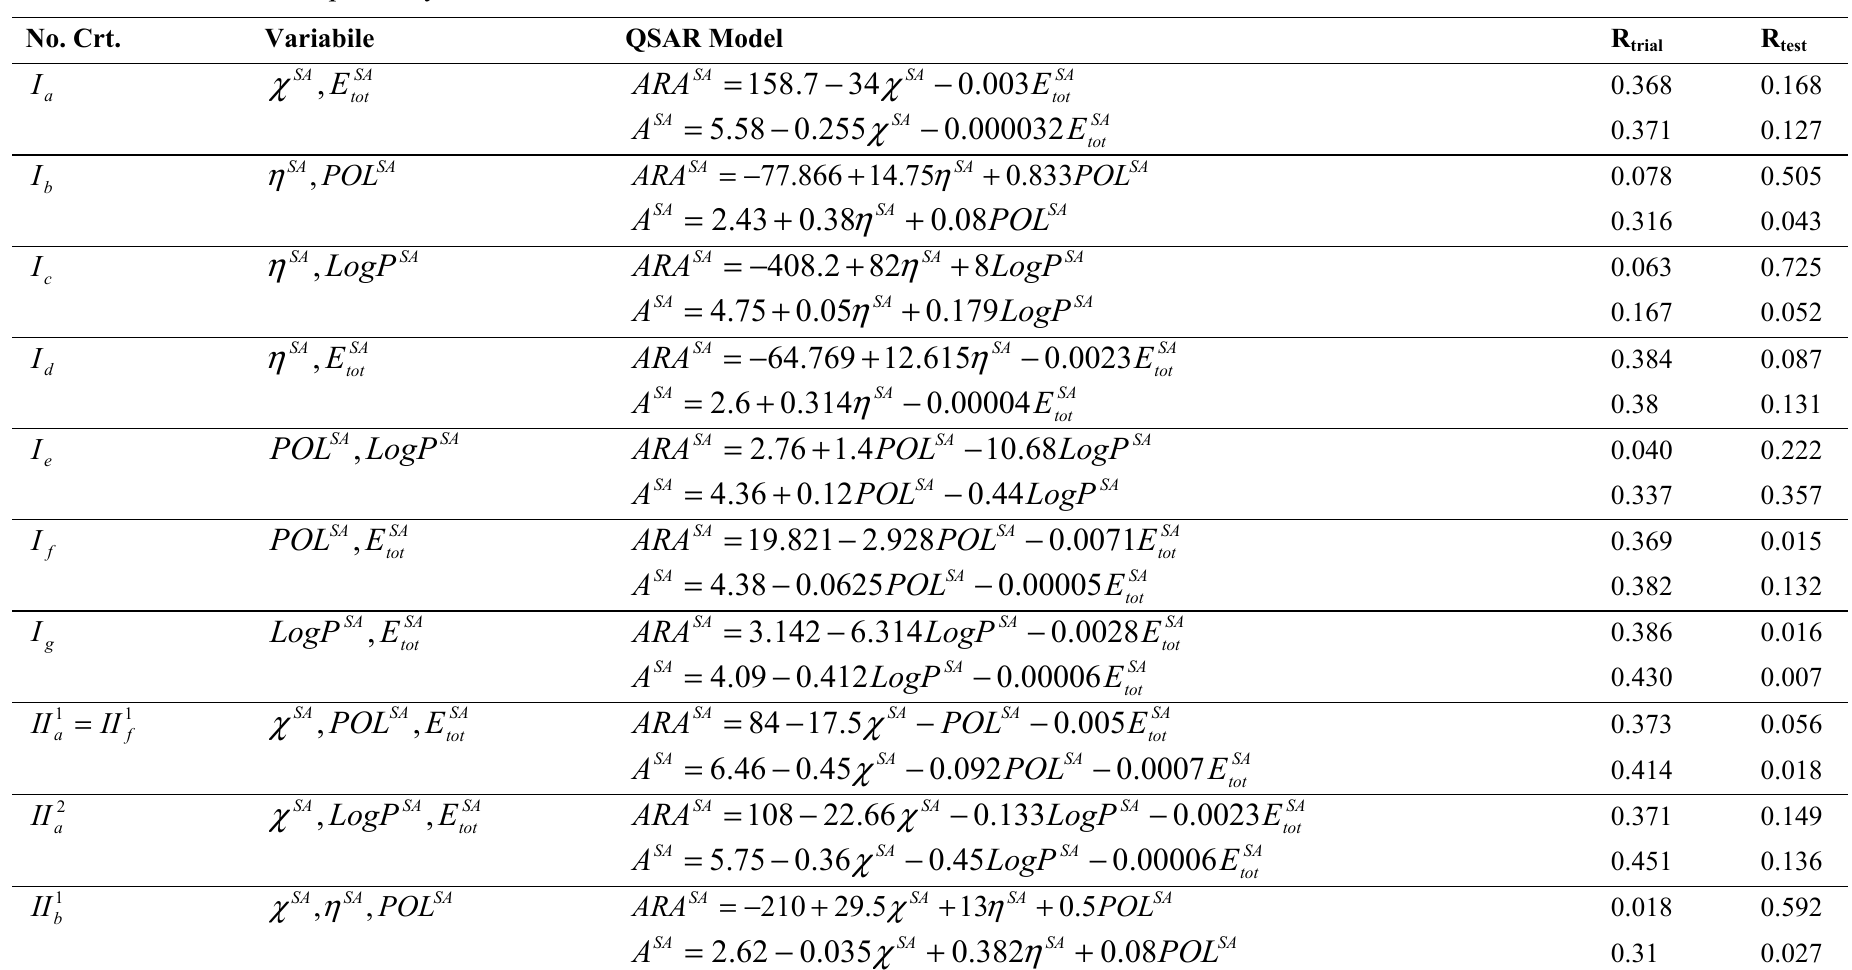
Table 6. Residual-alert QSARs for the models of Table 5 that fulfill Equation (10) with highest trial correlation factors. These are compared with the respective direct structural alert models of Table 3 using their correlation performances for the trial and test molecules in Tables 1 and 2,